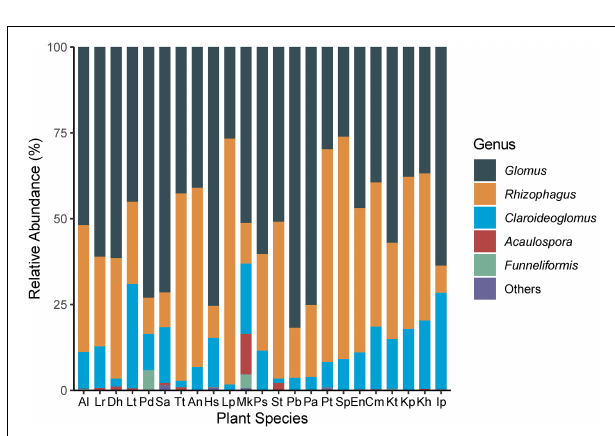
FIGURE 3 | Composition of AMF genera in roots of 23 plant roots. Al: Ajuga lupulina ; Lr: Lamiophlomis rotata ; Dh: Dracocephalum heterophyllum ; Lt: Lancea tibetica ; Pd: Plantago depressa ; Sa: Saussurea tibetica ; Tt: Taraxacum tibetanum ; An: Artemisia nanschanica ; Hs: Heteropappus semiprostratus ; Lp: Leontopodium pusillum ; Mk: Morina kokonorica ; Ps: Polygonum sibiricum ; St: Stracheya tibetica ; Pb: Potentilla bifurca ; Pa: Potentilla anserina ; Pt: Poa tibetica ; Sp: Stipa purpurea ; En: Elymus nutans ; Cm: Carex moorcroftii ; Kt: Kobresia tibetica ; Kp: Kobresia pygmaea ; Kh: Kobresia humilis ; Ip: Iris potaninii